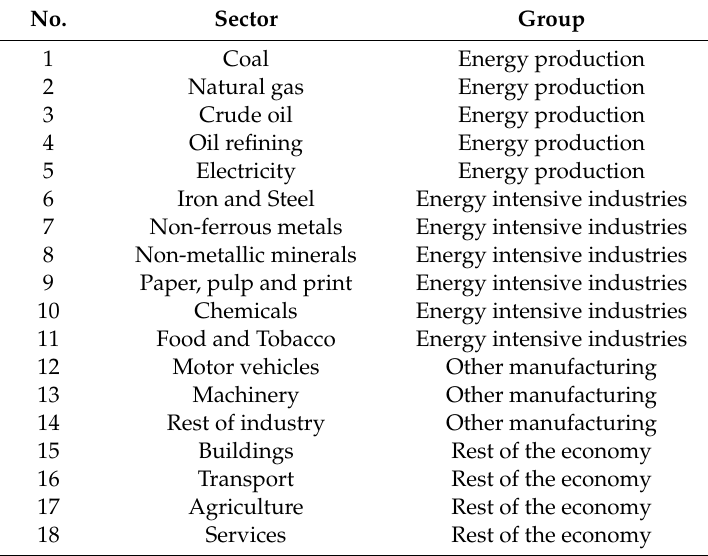
Figure A1. Regional disaggregation in NEWAGE. Each region in the model has its own color in the map. Table A1. List of production sectors in NEWAGE.